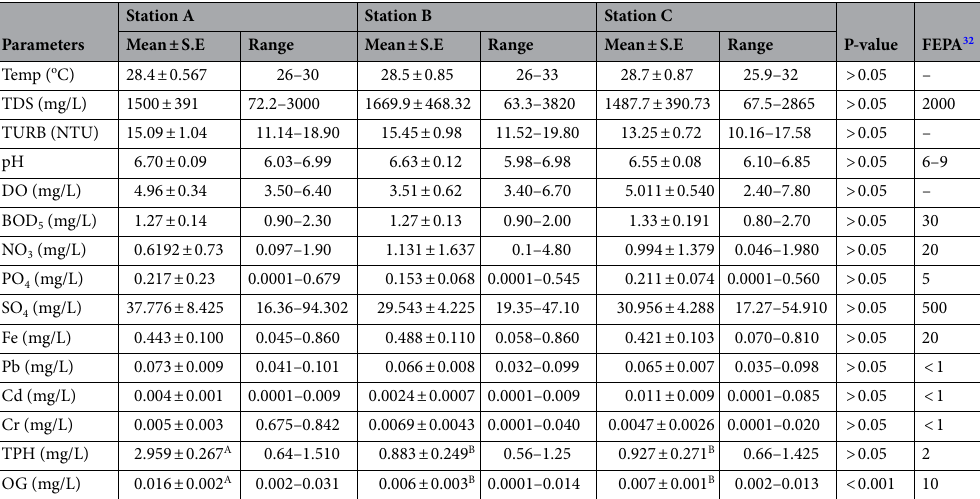
Table 3. Descriptive statistics of physicochemical characteristics of surface water of Egbokodo River, in comparison with the FMEnv limits. *P < 0.001 indicates a highly significant difference. P > 0.05 indicates that there is no significant difference. Sample size (N) = 9 months. Concentrations with different superscripts are significantly different in the order of A > B